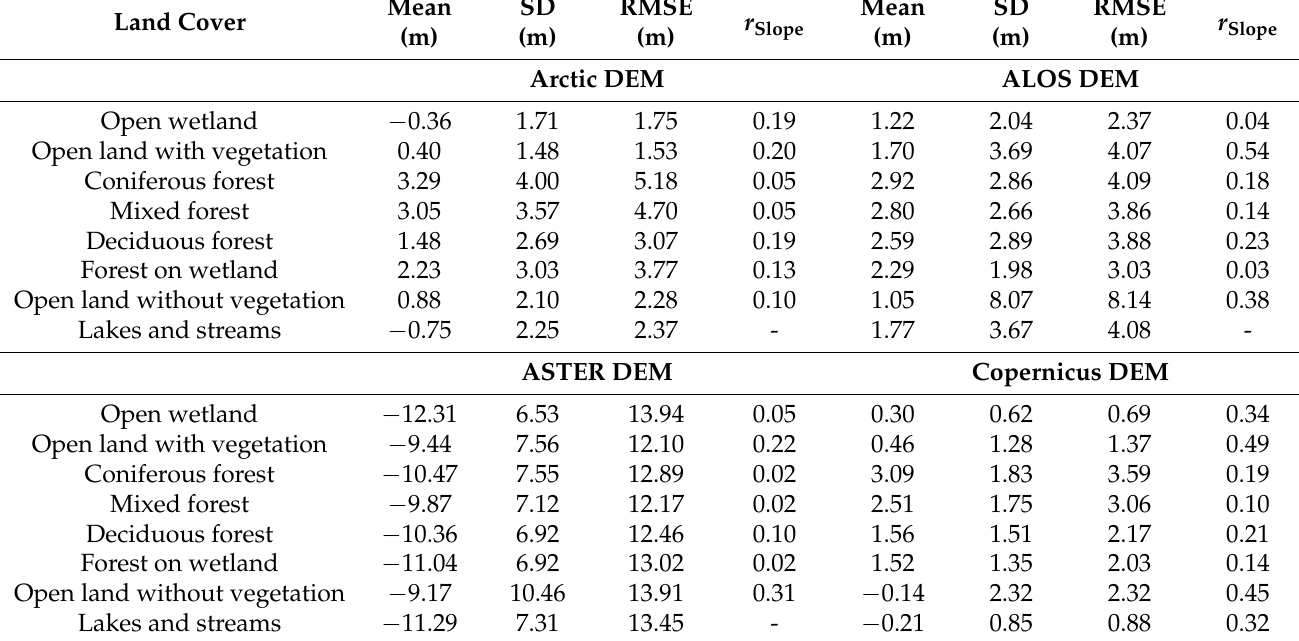
Table 4. Elevation error for four candidate DEMs in eight land cover classes (open wetland–OW, open land with vegetation–OlwV, coniferous forest–CF, mixed forest–MF, deciduous forest–DF, forest on wetland–FoW, open land without vegetation–OloV, lakes and streams–LK). r Slope is the correlation between vertical error and terrain slope derived from the reference